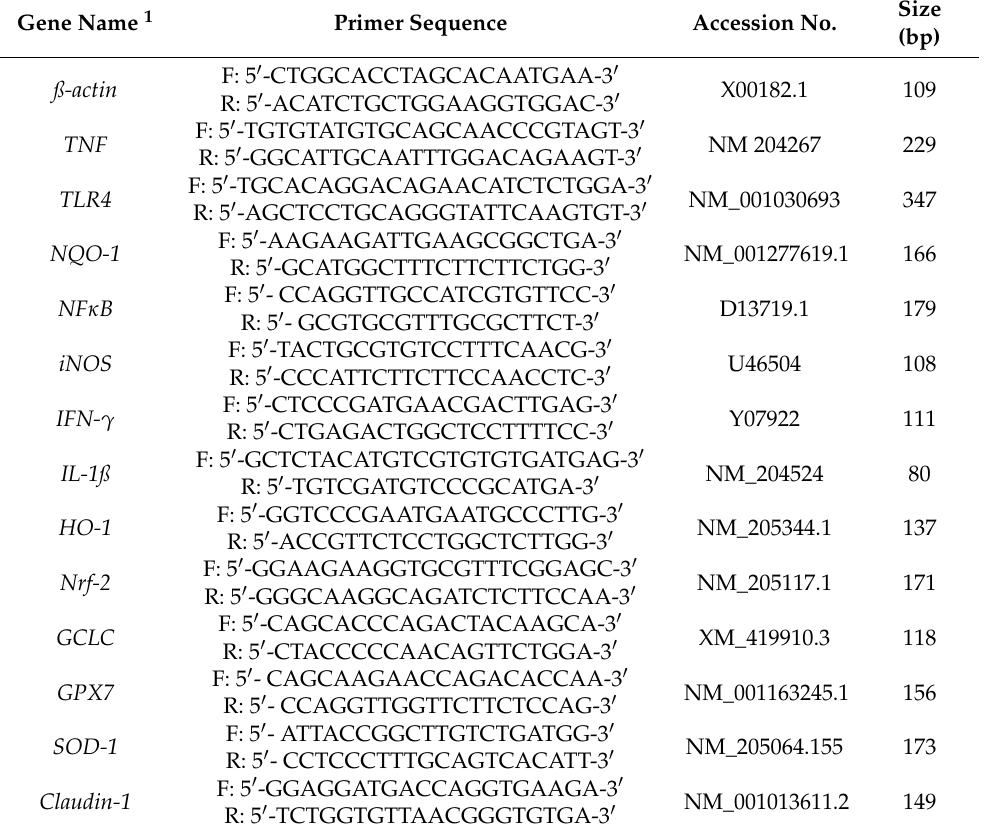
Table 2. The selected primer sequences of the Gallus gallus genes according to